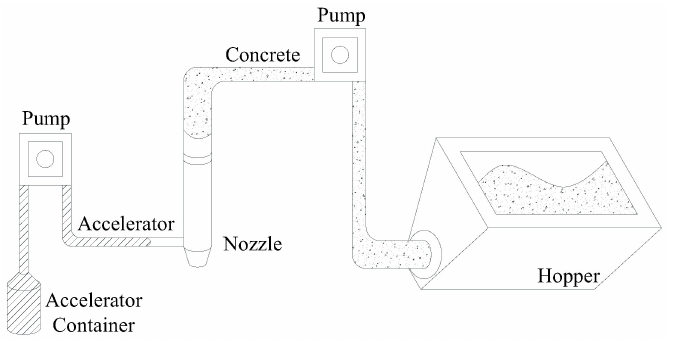
Figure 3. Schematic diagram of concrete